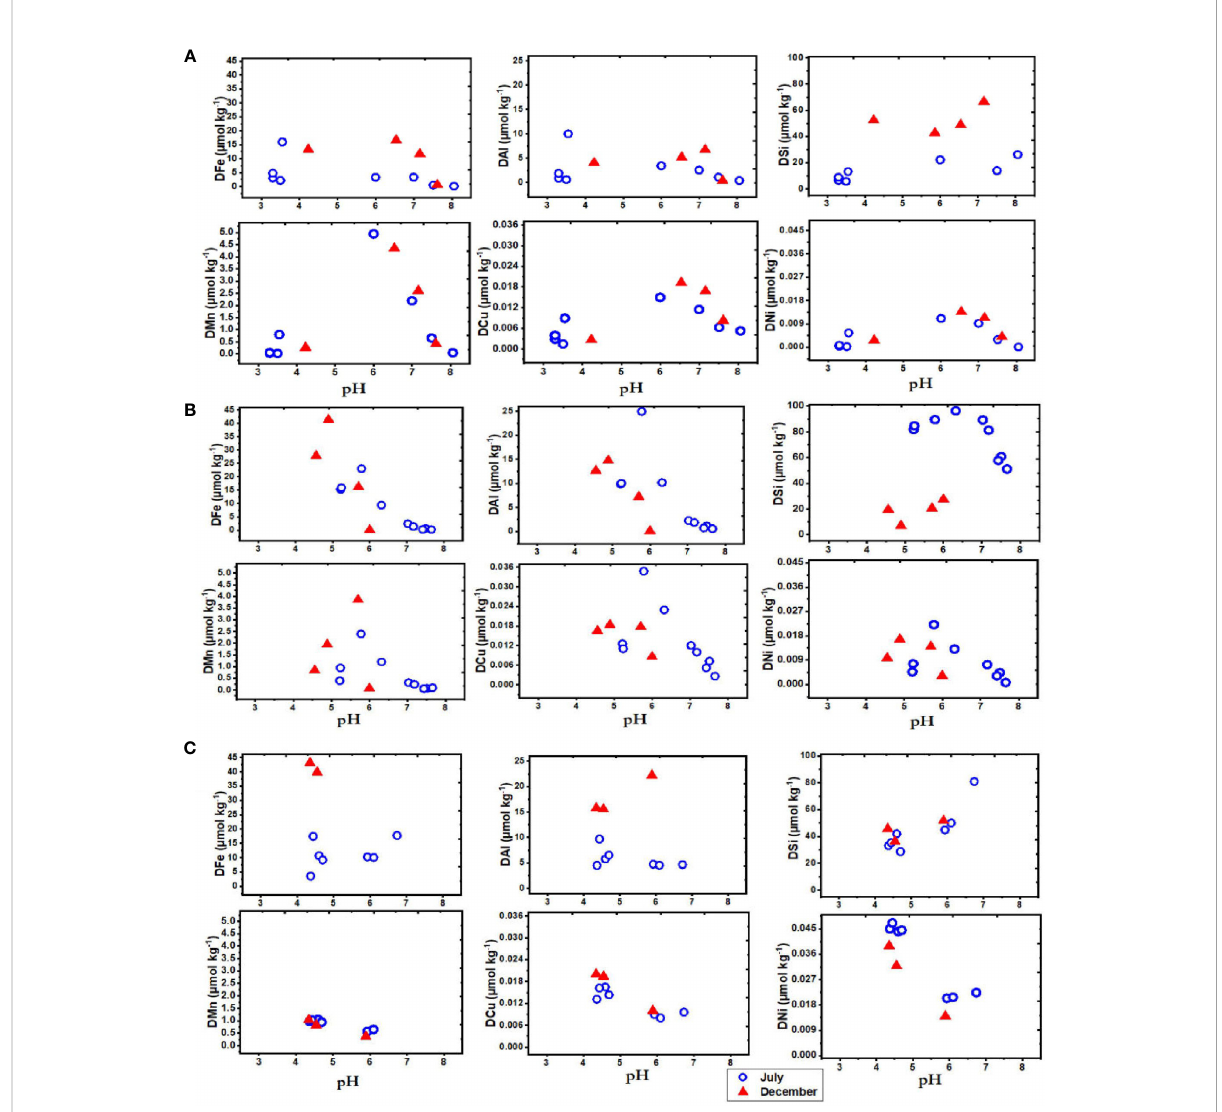
FIGURE 6 Dissolved elements as a function of pH in the blackwater rivers and estuaries of Borneo in July (dry) and December (wet), 2019. Each plot describes the distribution of elements (Fe, Al, Si, Mn, Cu and Ni) in (A) Maludam (B) Sebuyau (C) Belait rivers and